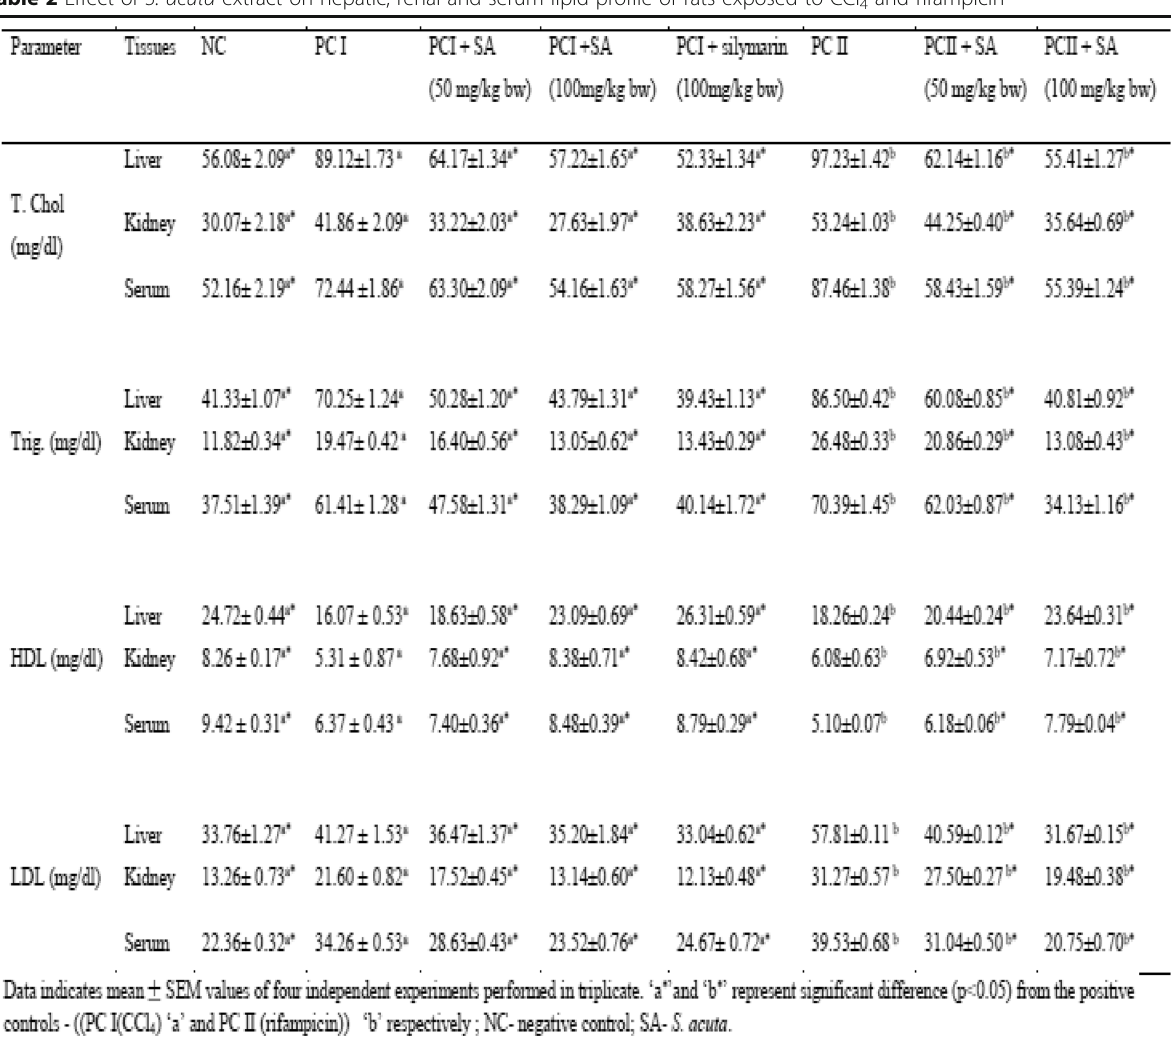
Table 2 Effect of S. acuta extract on hepatic, renal and serum lipid profile of rats exposed to CCI 4 and rifampicin